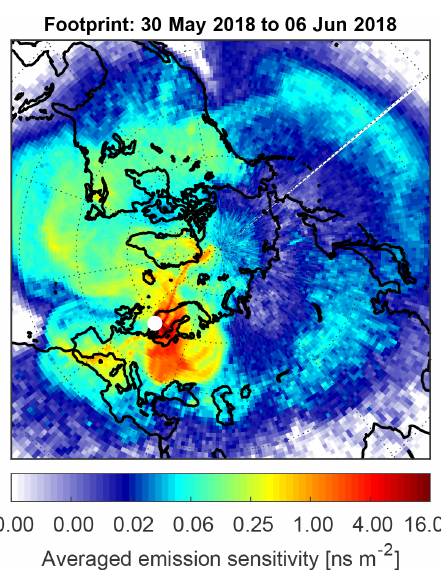
Figure 3. Footprint emission sensitivities calculated using the FLEXPART model for the 30 May–6 June 2018 period at the Birkenes